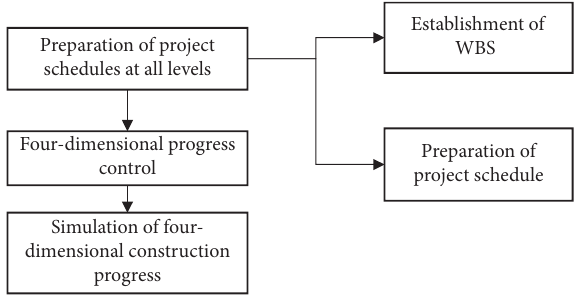
Figure 8: Construction progress simulation process. Table 3: Overall project